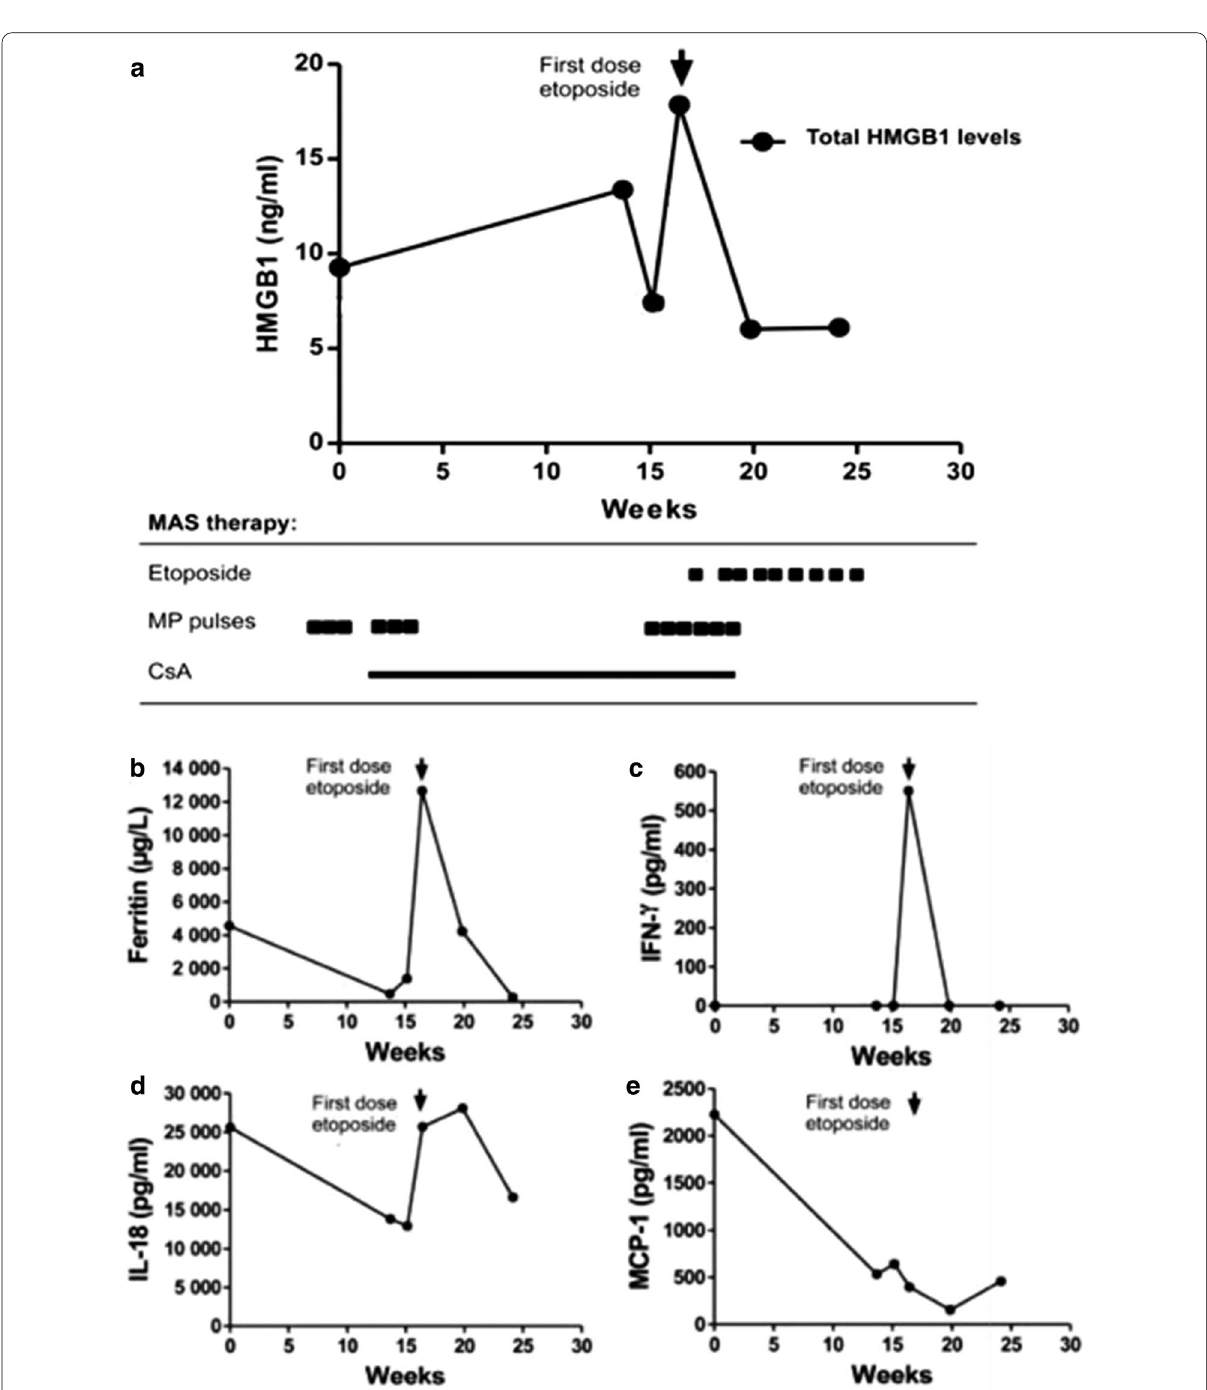
Fig. 5 Longitudinal serum analyses before and after introduction of etoposide treatment in patient #3. The progression of plasma HMGB1 levels is illustrated in a . The first two plasma samples were collected at onset of sJIA without MAS manifestations. The HMGB1 levels increased at onset of MAS and declined promptly after treatment with etoposide infusions. Increased serum concentrations of ferritin ( b ) and IFN‑γ ( c ) were documented during active MAS followed by a normalization post etoposide treatment. Serum IL‑18 levels ( d ) were distinctly increased during the entire observation period with peak values during active phases of MAS. Serum MCP‑1 levels did not reflect the clinical course ( e ). CsA: cyclosporine A; MP‑pulses: methylprednisolone